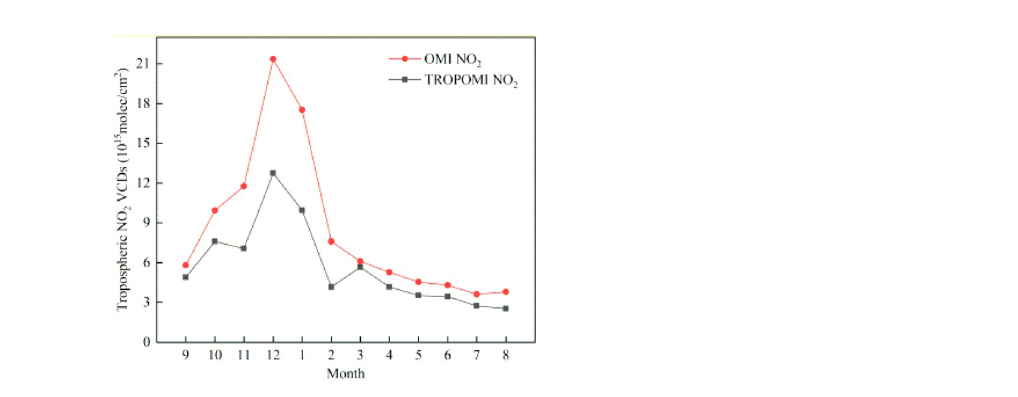
Figure 4. Monthly average trend of NO 2 VCDs of the COVID-19 early period from September 2018 to August 2019 in Henan